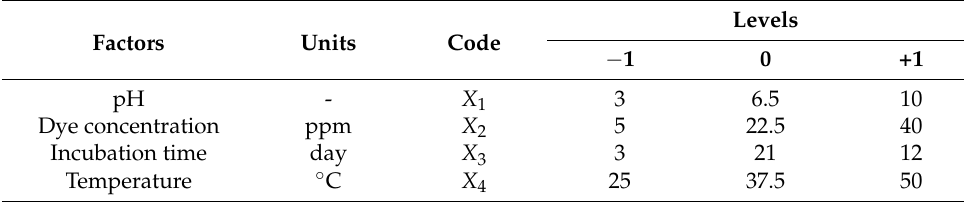
Table 2. Analysis of central composite design for the degradation of methyl red.